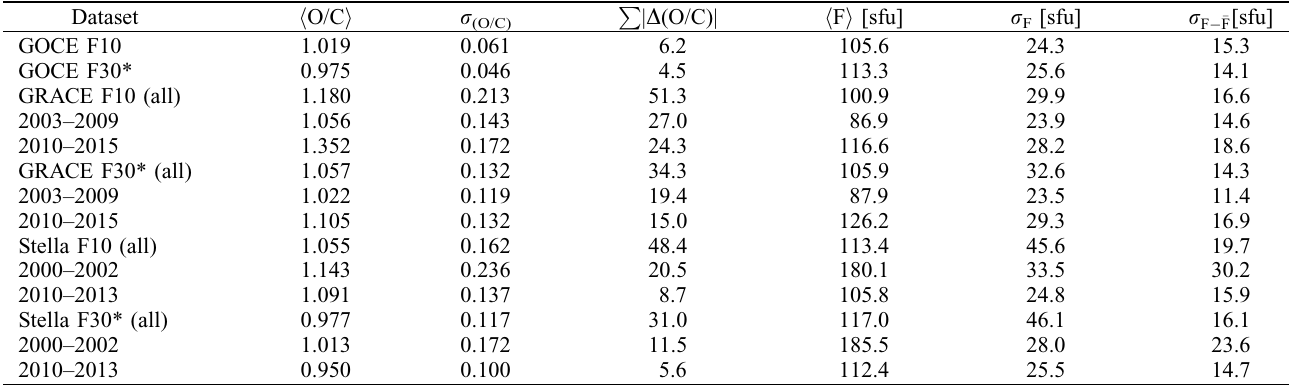
Table 2. Model comparisons to GOCE, GRACE and Stella density data, and solar activity as represented by the F10.7 and F30* radio fluxes; F stands for either F10.7 or F30*. The columns respectively describe: the dataset, the time average ( h O/C i ) and the standard deviation ( r (O/C) ) of the density ratio, the sum of the unsigned differenced density ratio for the given time interval ( P | D (O/C)|), the mean radio flux ( h F i ), its standard deviation ( r F ) and the standard deviation of the detrended flux ( r ), obtained by subtracting a 81-day F (cid:2) (cid:3) F